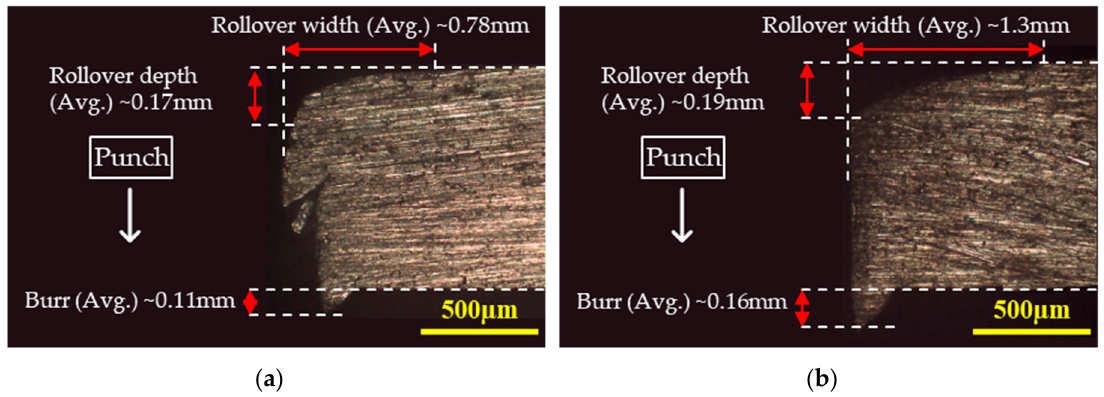
Figure 4. Side-view (OM) of the blanked edge obtained from experiments for 20% clearance at ( a ) 25 °C, indicating primary jagged fracture geometry and secondary curved fracture profile, and ( b ) 250 °C, indicating smooth sheared edge.